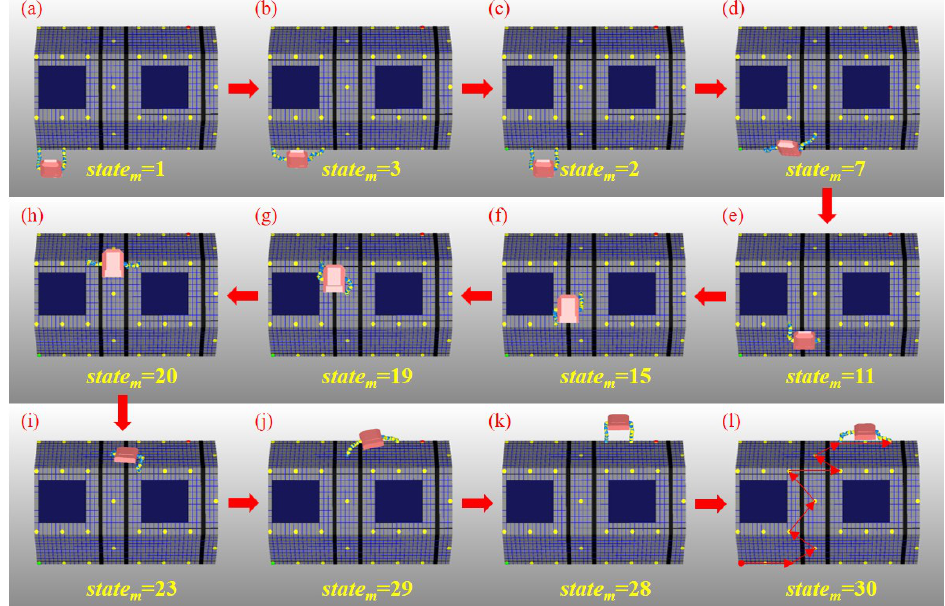
Figure 9. Sequential diagram of the autonomous movement simulation. ( a ) The state of the robot when standing at the initial point. ( b ) State after the 1st step. ( c ) State after the 2nd step. ( d ) State after the 3rd step. ( e ) State after the 4th step. ( f ) State after the 5th step.( g ) State after the 6th step. ( h ) State after the 7th step. ( i ) State after the 8th step. ( j ) State after the 9th step. ( k ) State after the 10th step. ( l ) State after the 11th step to reach the final